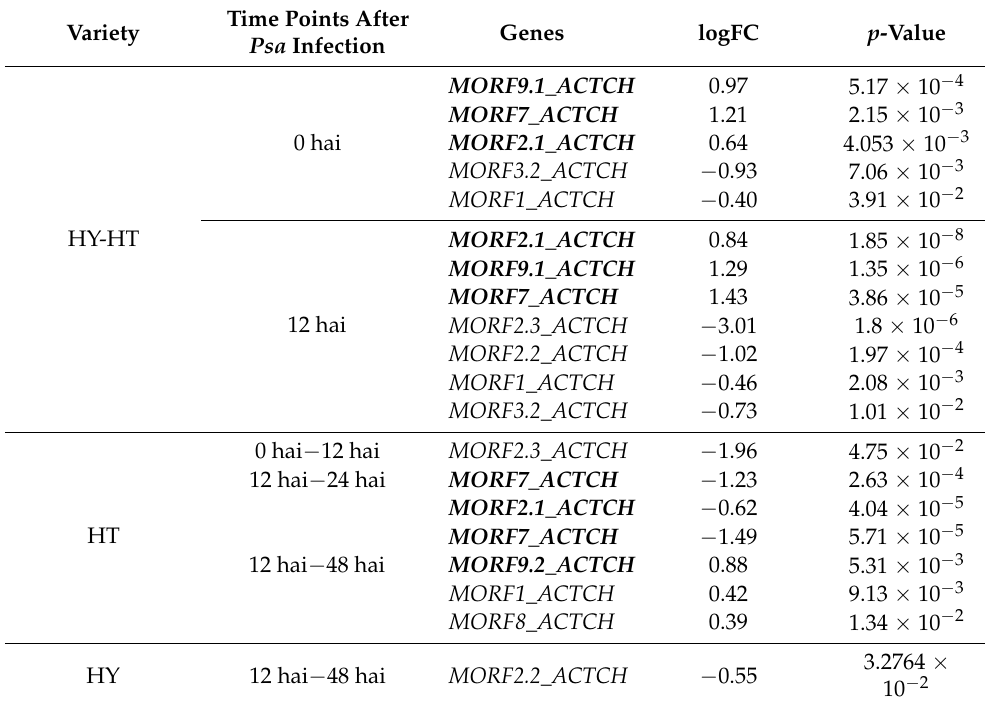
Table 3. Differentially expressed MORF genes between and within resistant (HT) and susceptible (HY) kiwifruit at different time points after Psa infection. Time Points After Genes logFC p -Value Variety Psa Infection